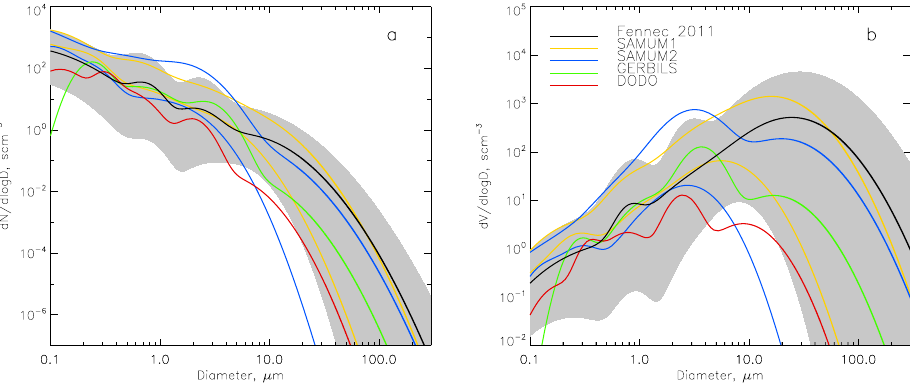
Fig. 6. Mean Fennec 2011 size distribution compared to those from other recent aircraft campaigns, for (a) number distribution and (b) volume distribution. Fennec size distribution is shown in black, with grey shading representing the minimum and maximum throughout the campaign. Other campaigns shown are SAMUM-1 (yellow lines), SAMUM-2 (blue lines), GERBILS (green line) and DODO flight b238 (red line). Where two lines are present in the same color they represent an envelope of size distributions (SAMUM-1 and SAMUM-2). GERBILS and DODO size distributions have been scaled by number concentrations typical of Fennec, as published values are normalised. The DODO size distribution is not corrected for refractive index.